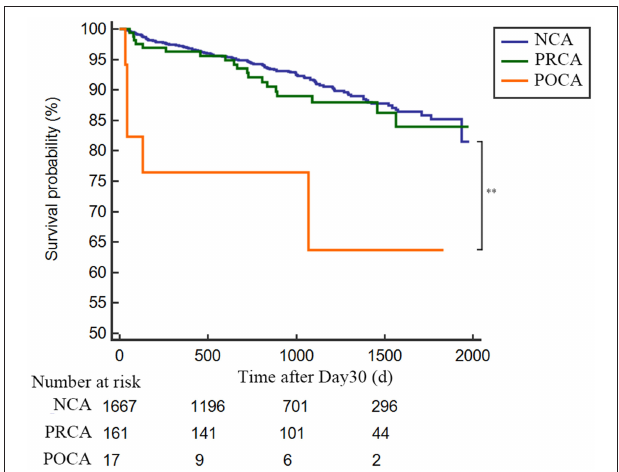
FIGURE 3 | Landmark analysis for long-term survival rate in 30-day survivors in AMI patients either complicated or not with cardiac arrest. Day 30 to long-term survival curves for NCA patients (blue line), PRCA patients (green line) and POCA patients (orange line). ** p < 0.001. NCA, non-cardiac arrest; POCA, post-revascularization cardiac arrest; PRCA, pre-revascularization cardiac arrest.